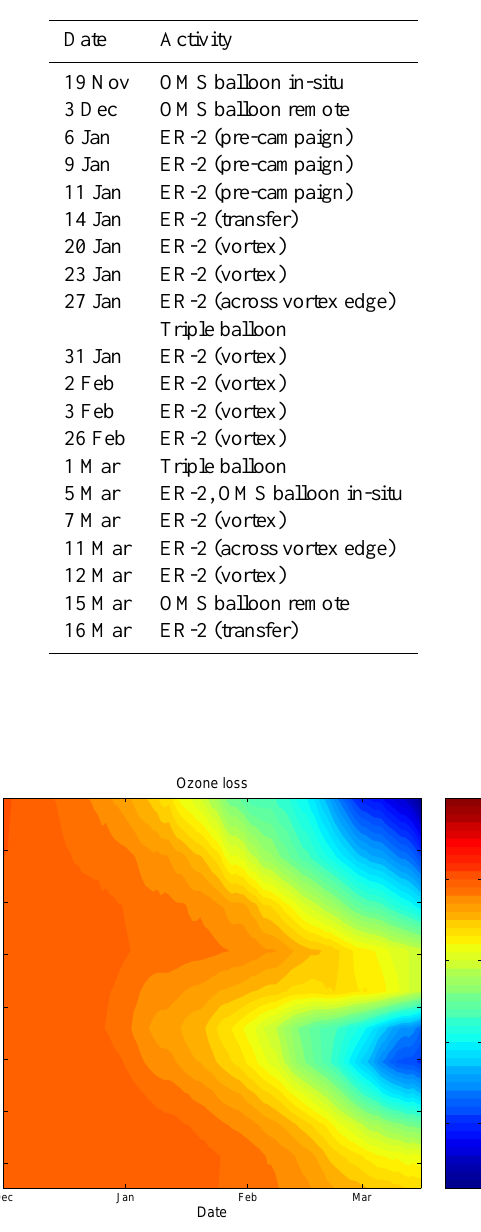
Table 6. Time table of the measurements.